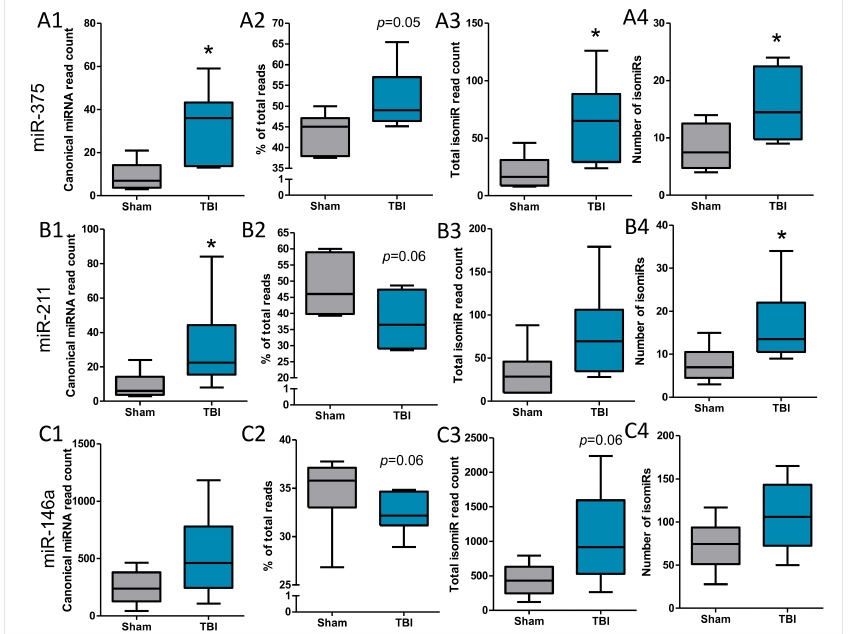
Figure 6. Analysis of canonical (miRbase) miRNA sequence and isomiRs of miR-375, miR-211, and miR-146a. ( A1–A4 ) Read count of canonical miR-375 was increased, ( A1 ) p < 0.05 and there was a trend toward its proportional increase from all miR-375 aligned reads; ( A2 ) p < 0.1. Additionally, the total isomiR read count ( A3 ) p < 0.05 and number of isomiRs ( B4 ) p < 0.05, were increased. (( B1 – 4 ) Similarly, the read count of canonical miR-211 was increased, ( B1 ) p < 0.05 and there was a trend toward its proportional increase from all miR-211 aligned reads; ( B2 ) p < 0.1. Total isomiR read count ( B3 ) p > 0.05 was not changed, but the number of isomiRs ( B4 ) p < 0.05 was increased. ( C1–C4 ) For miR-146a, we observed no significant changes. The trends for canonical miRNA were opposite for cortical differentially expressed miRNAs (miR-375 and miR-211), however, as the proportion of canonical miR-146a was decreased compared to all sequences aligned to it, p < 0.1. Statistical significance: *, p <